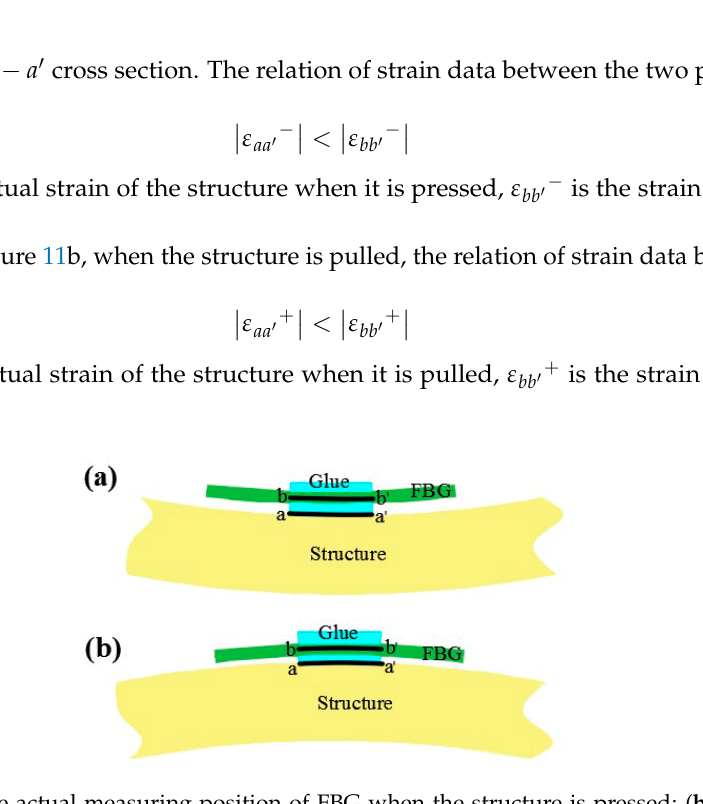
Figure 11. ( a ) The actual measuring position of FBG when the structure is pressed; ( b ) the actual measuring position of FBG when the structure is pulled.